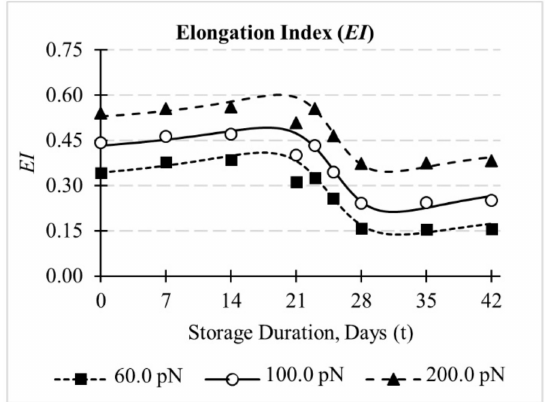
Figure 7. Evolution of elongation index ( EI ) of stored RBCs (discocyte at 0 ≤ t < 20; echinocyte I at 20 ≤ t < 22; echinocyte II at 22 ≤ t < 24; echinocyte III at 24 ≤ t < 26; and sphero-echinocyte at 26 ≤ t ≤ 42) at the total optical tweezers stretching forces of F ext = 60, 100 and 200